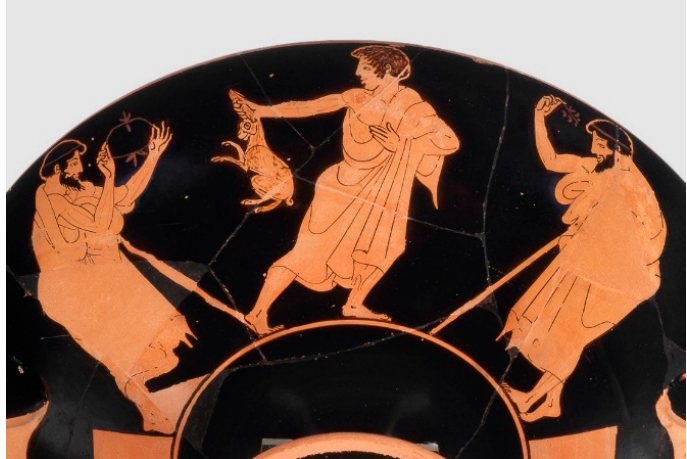
Figure 8. Interior of Figure 7. Munich, Antikensammlungen 2658. Photo courtesy Staatliche Antikensammlungen und Glyptothek München. Photograph by Renate Kühling. Used by permission. 480/70 BCE.